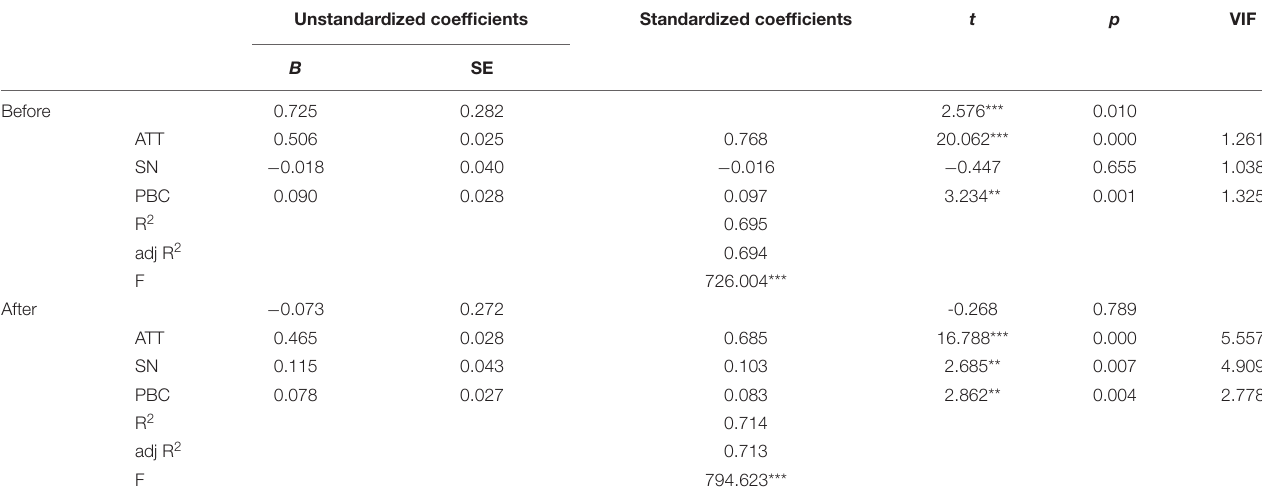
TABLE 4 | Multiple linear regression analysis.